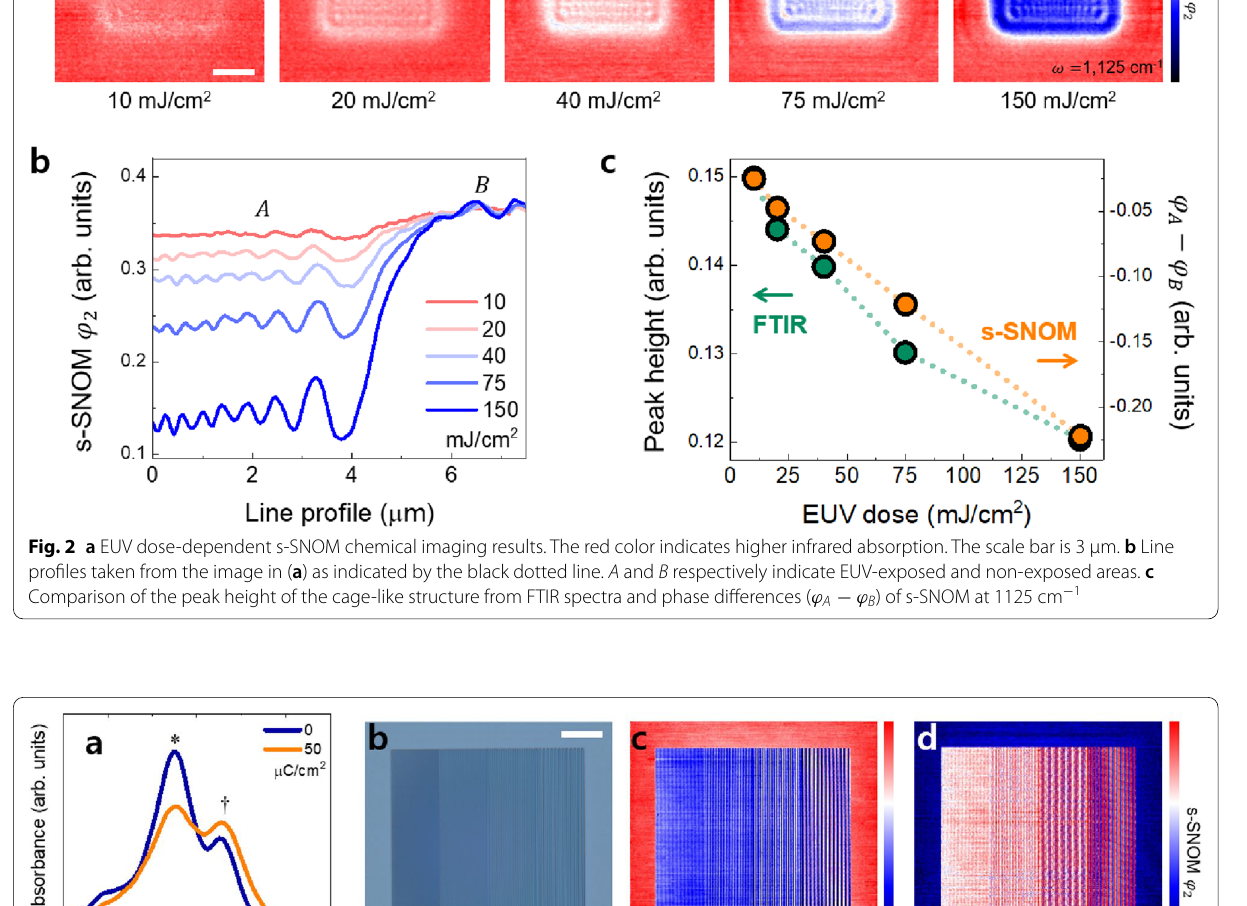
odic 1:1 pattern. Meanwhile, the images on the bottom